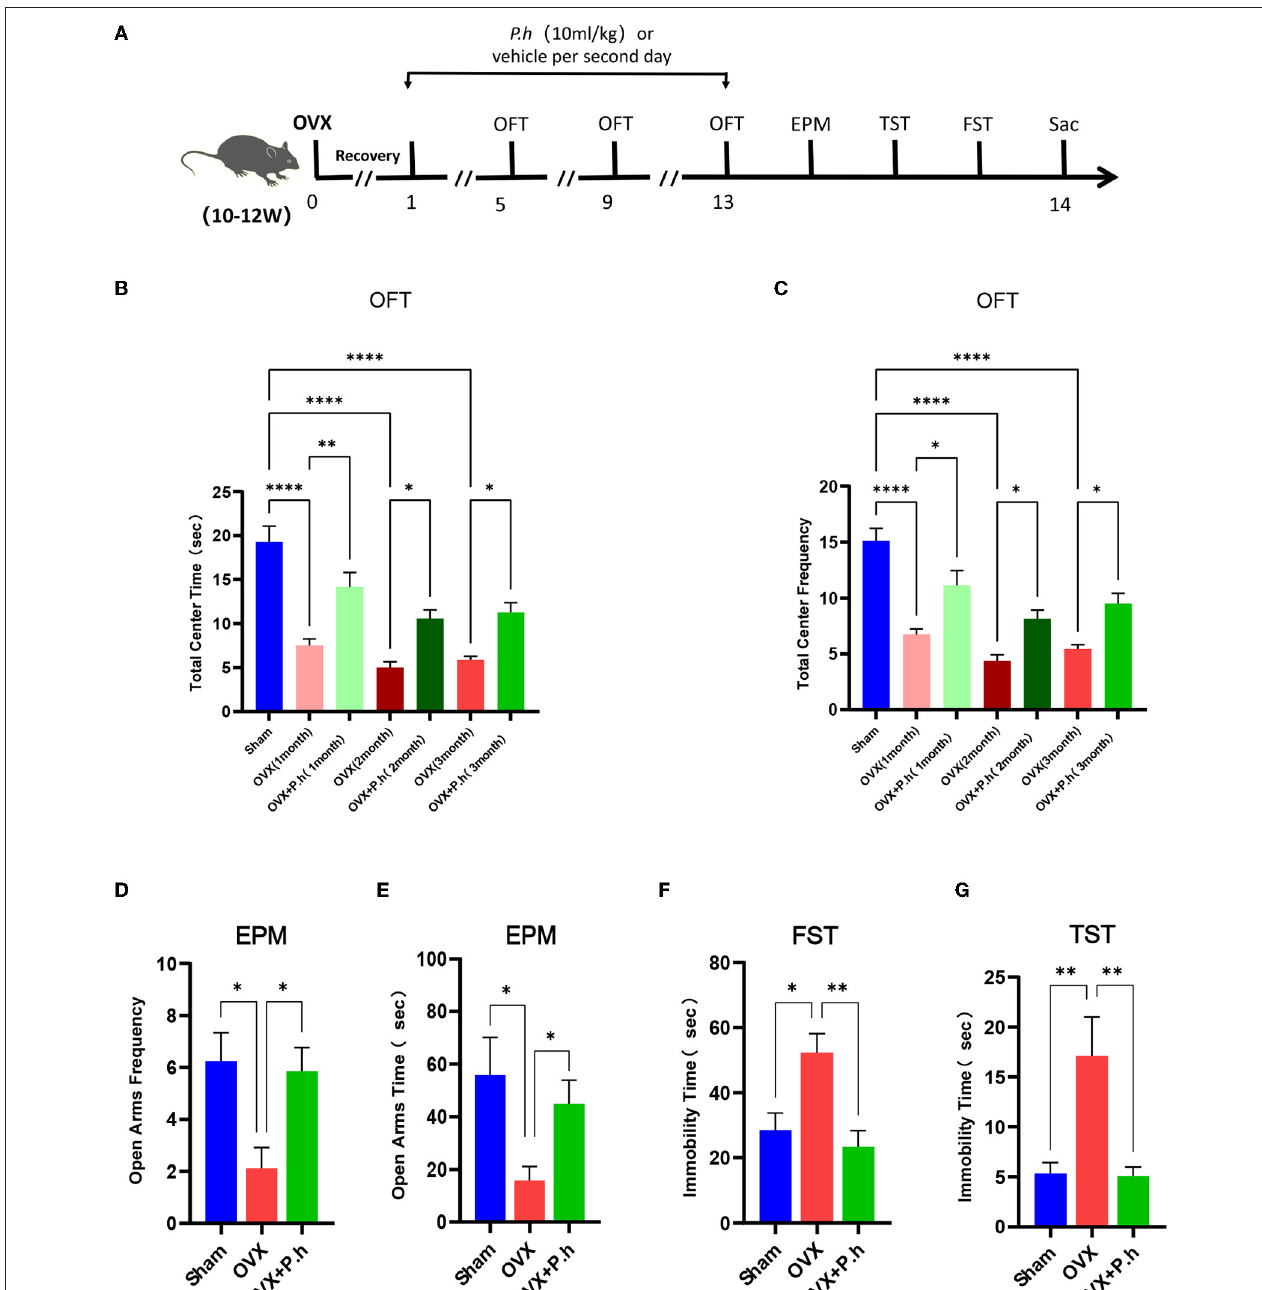
FIGURE 1 | P. histicola alleviated the depression-like behaviors in OVX mice. The mice were ovariectomized or sham operated and then given 1 × 109 CFU P. histicola medium per 2 days for 12 weeks. The sham group and OVX group were given the same volume of sterile medium. The depression-like behavior was measured by OFT, EPM, TST, and FST. (A) Schematic diagram of the experimental procedures. (B) Central area time of OFT. (C) Transition times of OFT. (D) Total time in open arms of EPM. (E) Transition times in open arms of EPM. (F) Immobility time of TST. (G) . Immobility time of FST. Data are presented as means ± SEM ( n = 7–8/group). * p < 0.05, ** p < 0.01, **** p < 0.0001.